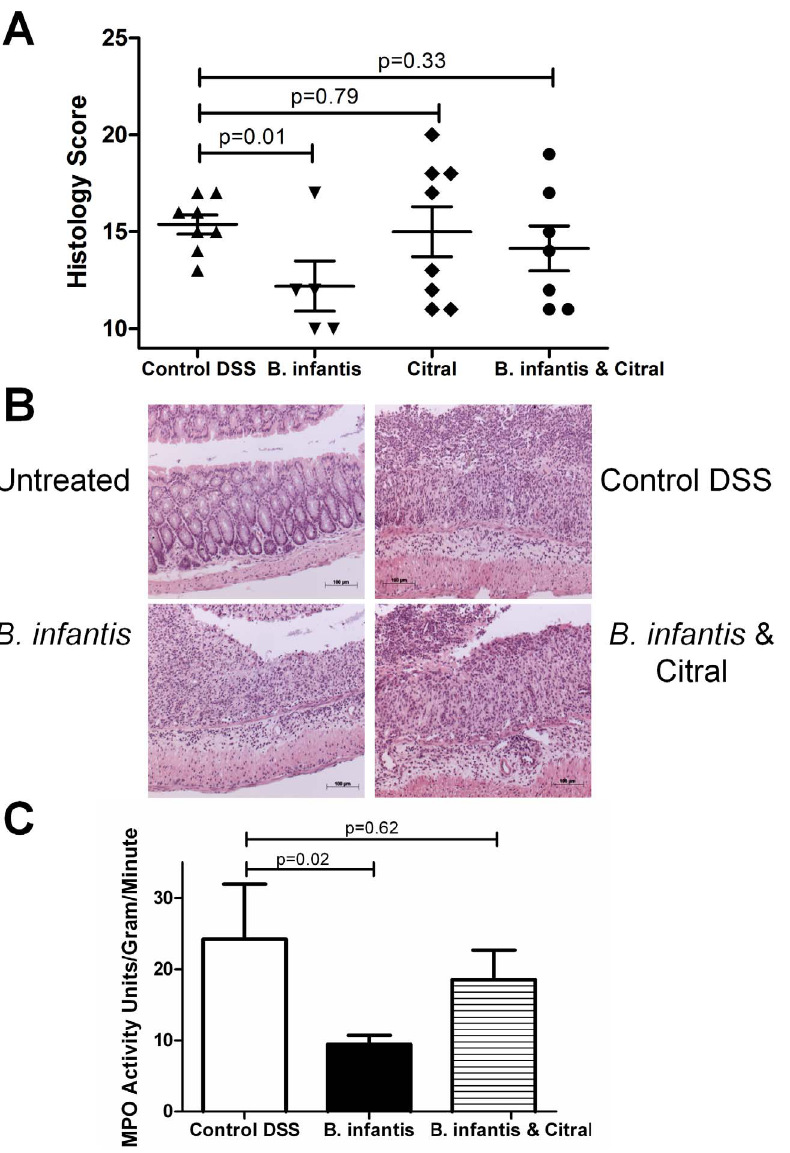
Figure 5. DSS-induced colitis is reduced by B.infantis feeding. Four murine study groups were examined – Untreated (no DSS and no B. infantis ), Control (DSS alone), B. infantis (DSS and B. infantis ), citral (DSS and citral) and B. infantis & citral (DSS, B. infantis and citral). ( a ) The histopathology inflammatory score was significantly reduced by B. infantis feeding (n=5), but not when citral was co-administered (n=8). Citral administered with DSS did not increase inflammation in the colon in comparison to DSS alone (n=7). ( b ) Representative slides of the murine gut are illustrated. ( c ) Colonic myeloperoxidase (MPO) levels were reduced in B. infantis -fed mice, which was not observed with B. infantis and citral treatment. Statistical significance was determined using non-parametric Mann-Whitney tests.